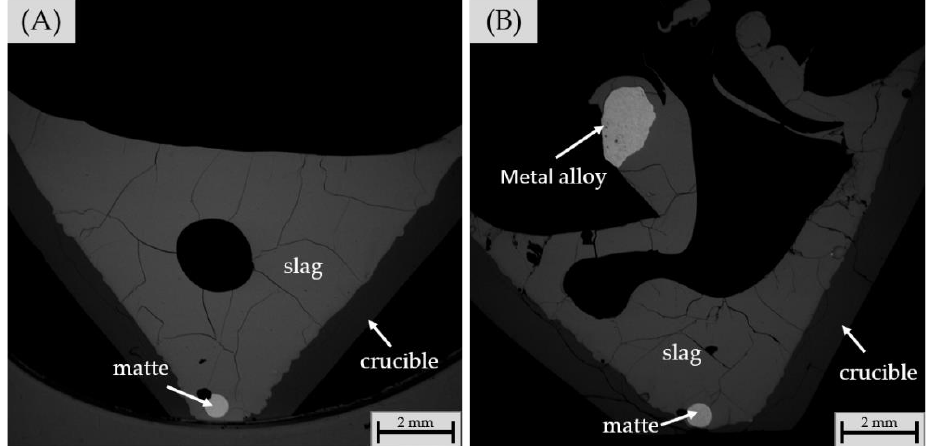
Figure 13. General microstructure of samples. ( A ) Sample without SB addition after 60 min contact time; ( B ) Sample with 10 wt.% of SBs added on top of the slag after 60 min contact time.